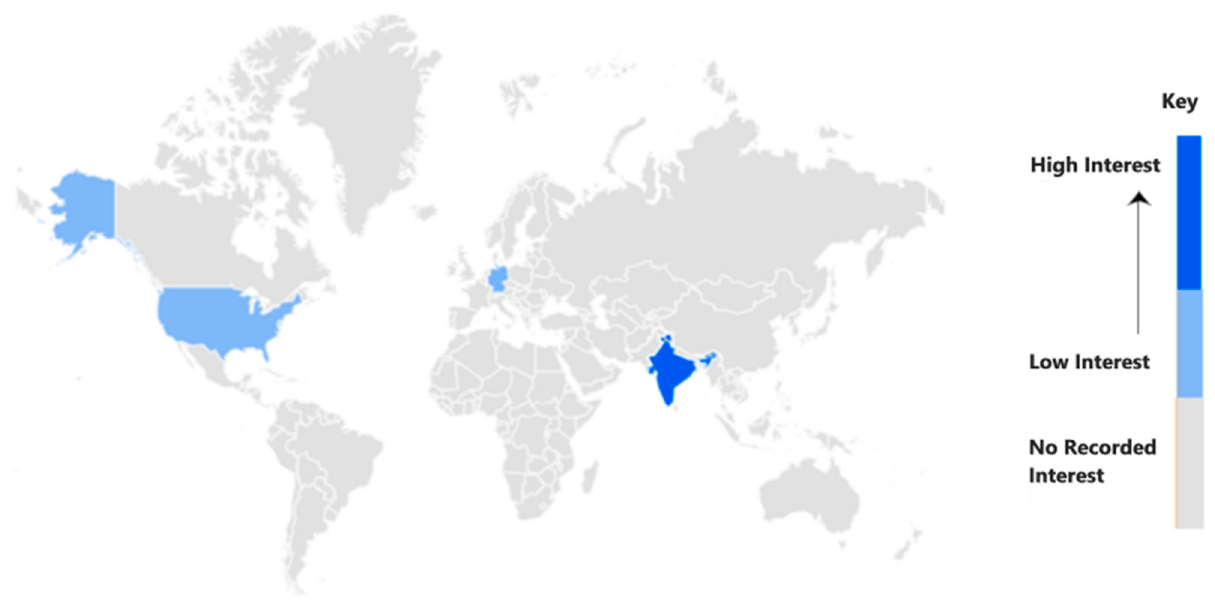
Figure 6. Map illustrating the interest in solar–wind hybrid energy over the past 5 years [15].